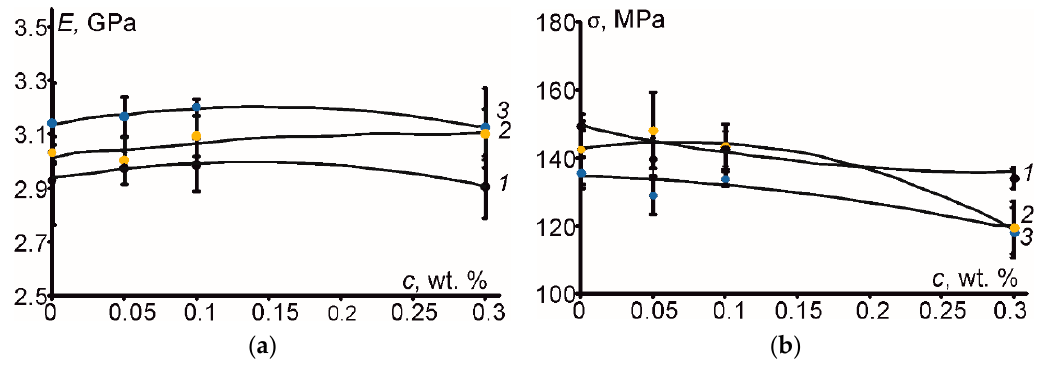
Figure 6. ( a ) Elastic modulus and ( b ) flexural strength before ( 1 ) and after 4 weeks of the hydrothermal aging vs. carbon nanofiller’s (-s’) weight content heated at 70 °C ( 2 ) or immersed in water at 70 °C ( 3 ) (dots—experimental data, lines—polynomic approximations).